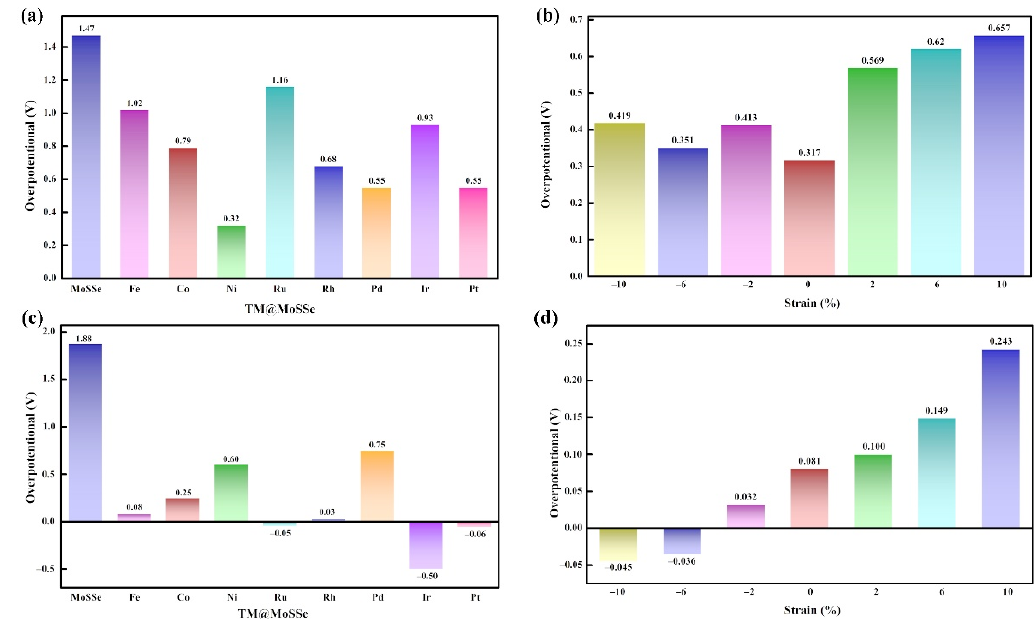
Figure 3. The OER overpotential of ( a ) TM@MoSSe and ( b ) Ni@MoSSe under different strain; the HER overpotential of ( c ) TM@MoSSe and ( d ) Fe@MoSSe under different strain.